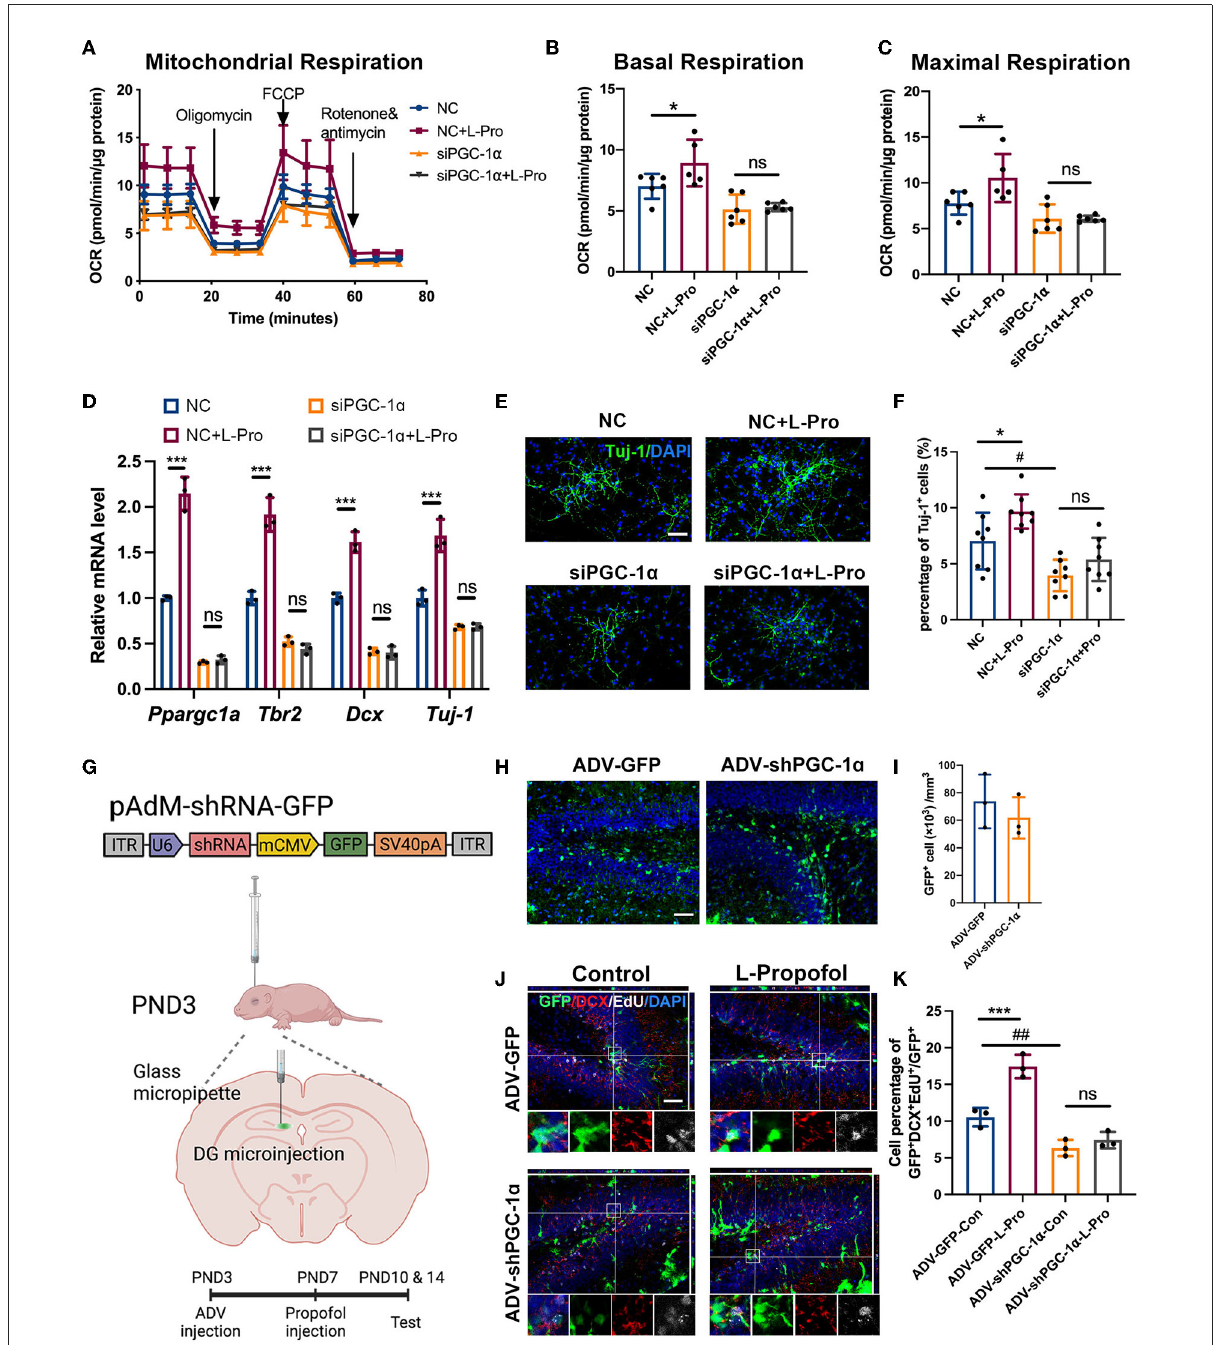
FIGURE6 Low-dose Propofol promoted neurogenesis via activating PGC-1 α -induced mitochondrial OXPHOS. (A–C) Administration of siPGC-1 α prevented low-dose Propofol-induced mitochondrial OXPHOS promotion in primary NSCs measured by the (A) normalized OCR; including (B) basal respiration (NC vs. NC + L-Pro: p = 0.017, siPGC-1 α vs. siPGC-1 α + L-Pro: p = 0.803) and (C) maximal respiration (NC vs. NC + L-Pro: p = 0.010, siPGC-1 α vs. siPGC-1 α + L-Pro, p = 0.996), suggesting the dominant role of PGC-1 α in Propofol-induced OXPHOS. N = 5–6. (D–F) siPGC-1 α abolished neurogenesis elevation in primary NSCs differentiation determined by (D) relative mRNA level (Ppargc1a: NC vs. NC + L-Pro: p < 0.001, siPGC-1 α vs. siPGC-1 α + L-Pro: p = 0.979; Tbr2: p < 0.001, p = 0.776; Dcx: p < 0.001, p = 0.996), and Tuj-1: p < 0.001, p > 0.999. N = 3) and staining with Tuj-1(green) (E,F) (NC vs. NC + L-Pro: p = 0.047, siPGC-1 α vs. siPGC-1 α + L-Pro: p = 0.444, NC vs. siPGC-1 α : p = 0.015. N = 8). Scale bar, 50 µ m. Error bars, mean ± SD. * (NC vs. NC + L-Pro): p < 0.05; *** p < 0.001; # (NC vs. siPGC-1 α ): p < 0.05. (G) Schematic diagram of stereotactic virus injection. (H,I) Confocal images of maximum intensity projection (H) and quantification (I) of adenovirus infection cell (green) after microinjection in DG in PND10. Scale bar, 50 µ m. (J,K) Confocal image of EdU (gray) and DCX (red) staining with z-plane projections (J) and quantification (K) of the percentage of GFP + /DCX + /EdU + (showing newborn neurons) in GFP + infected cells in the